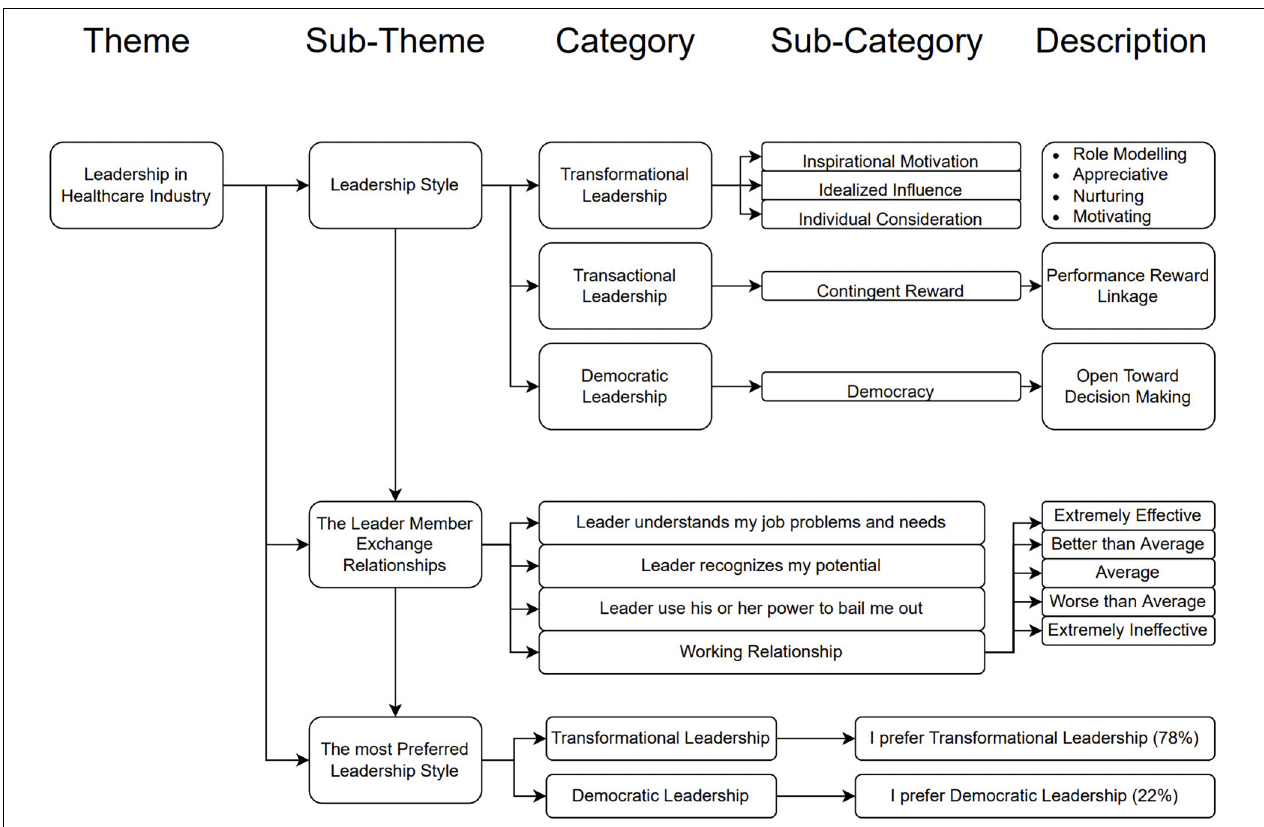
FIGURE 1 | Coding mapping leadership styles in healthcare